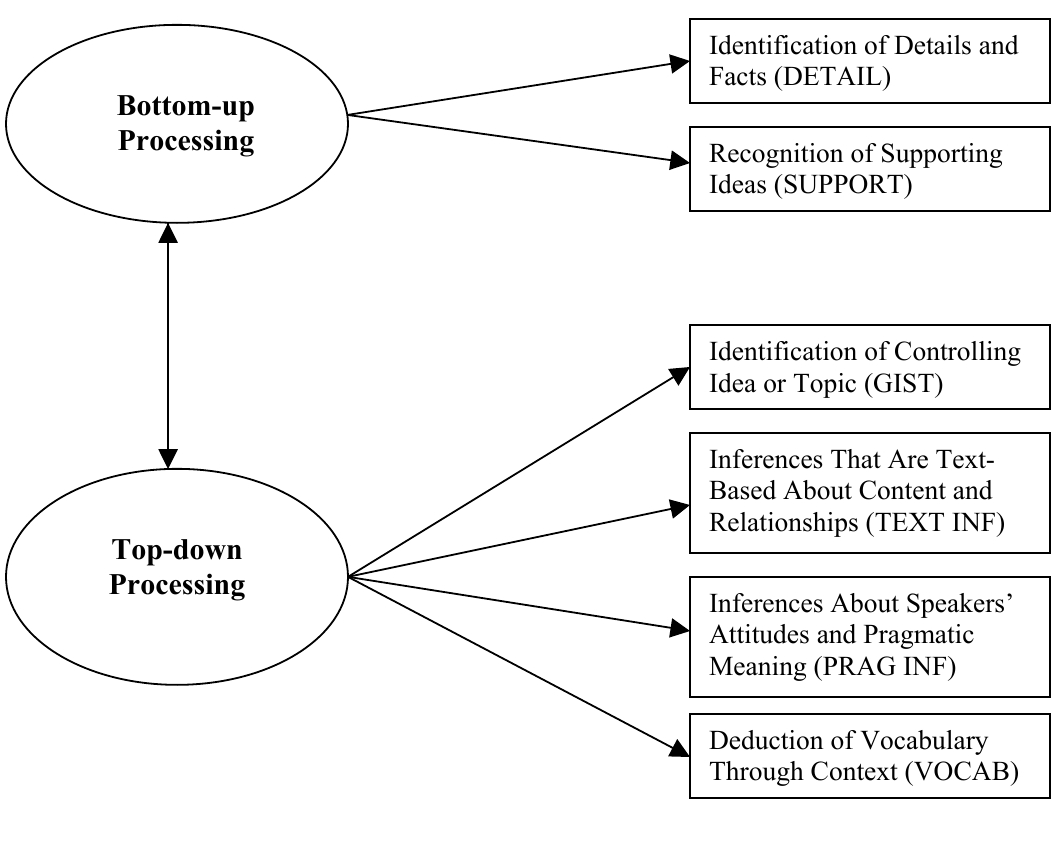
Operationalization of a Model of Second Language Listening Comprehension Bottom-up Processing